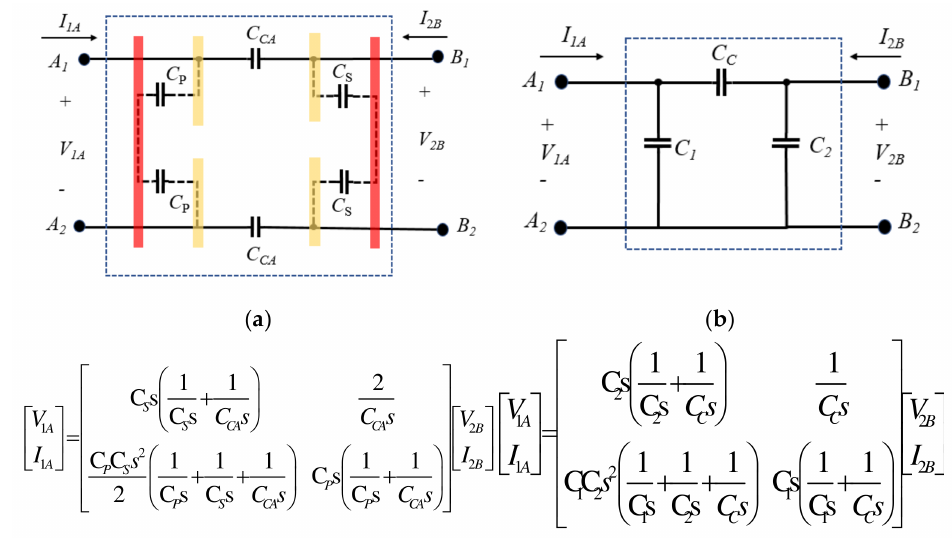
Figure 3. S-CPT coupler. ( a ) Coupler with the capacitance model. ( b ) Equivalent circuit of the